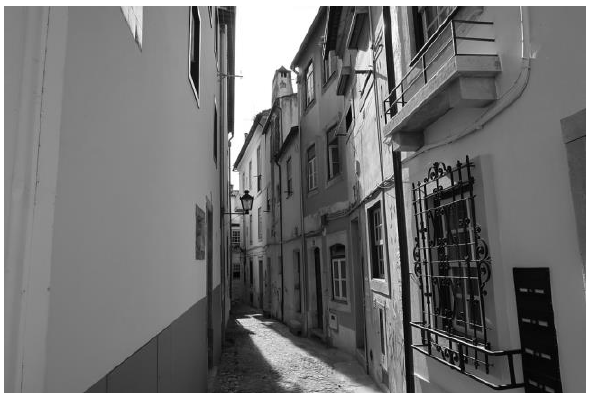
Figure 1. View to a typological inner street of the historic centre of Coimbra.